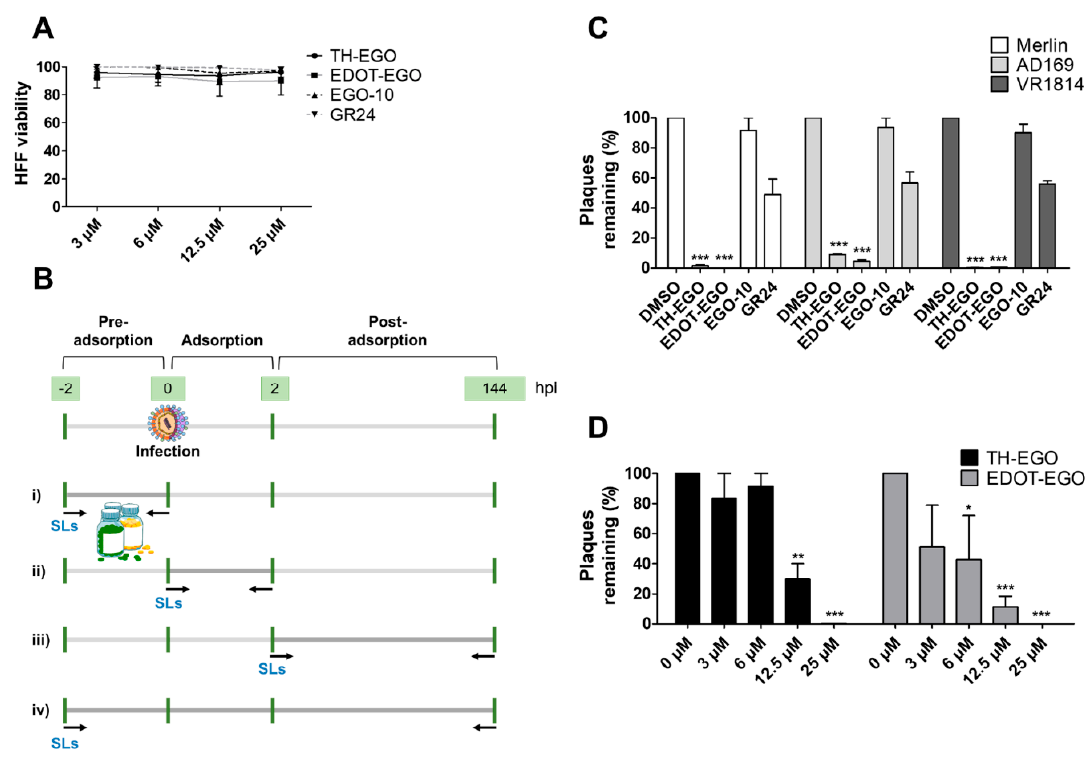
Figure 1. SL analogs antiviral activity against the human cytomegalovirus (HCMV). ( A ) Cell viability was measured using the 3-(4,5-dimethylthiazol-2-yl)-2,5-diphenyltetrazolium bromide (MTT) assay. Confluent human foreskin fibroblast (HFF) cultures seeded in 96-well plates were incubated with different concentrations of the indicated SLs for 144 h. Graphs are representative of three independent experiments with duplicate replicate wells for each analysis. ( B ) Flow-charts of time-of-addition assays. ( C ) Identification of SL-analogs with anti-HCMV activity. HFF cells were cultivated in 24-well plates and pre-treated with 25 µM of the indicated SLs for 2 h. Subsequently, cells were infected with the indicated HCMV strains (MOI of 0.1) and, following virus adsorption (2 h at 37 °C), the viral inoculum was removed; cultures were exposed to SLs during the infection, for 144 h. Dimethyl sulfoxide (DMSO) was used as the vehicle control. The extent of HCMV replication was then assessed by titrating the infectivity of supernatants and cell-associated viruses—obtained from freeze (liquid nitrogen)/thaw (37 °C) cycles—and combined using a standard plaque assay in HFFs. Plaques were microscopically counted, and the mean plaque counts for each molecule were expressed as a percentage of the mean plaque count of the control. Three independent experiments were performed, and one representative experiment is shown (***, p < 0.001, two-way ANOVA followed by Bonferroni’s post-tests). ( D ) HFFs were infected with HCMV (Merlin strain, MOI of 0.1) and, where indicated, the cells were treated with increasing concentrations of TH-EGO, EDOT-EGO or DMSO, before and during virus adsorption. These remained in the culture media throughout the experiment. The extent of HCMV replication was then assessed by titrating the infectivity of supernatants and cell-associated viruses—obtained from freeze (liquid nitrogen)/thaw (37 °C) cycles—and combined using a standard plaque assay. Plaques were microscopically counted, and the mean plaque counts for each drug concentration were expressed as a percentage of the mean count of the control. The number of plaques was plotted as a function of drug concentration. Three independent experiments were performed, and one representative experiment is shown (*, p < 0.05; **, p < 0.01; ***, p < 0.001, two-way ANOVA followed by Bonferroni’s post-tests). To further evaluate whether the antiviral activity of the SL analogs was limited to HCMV or whether it could be extended to other members of the Herpesviridae family, we assessed their e ffi cacy against herpes simplex type 1 (HSV-1) and type 2 (HSV-2) (Figure S1). MTT viability assays on VERO cells after 48 h of treatment were used to establish that a dose of 12.5 µ M was associated with